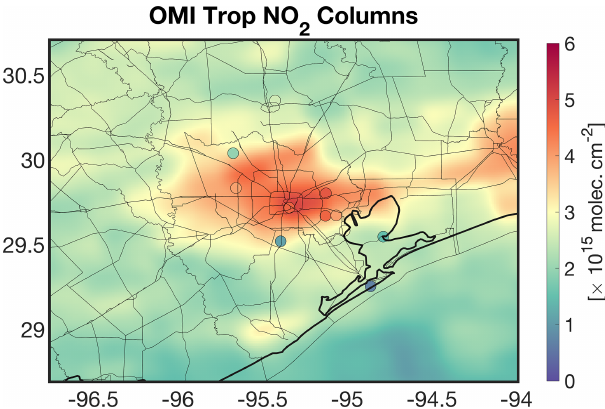
Figure 12. The spatial distribution of OMI tropospheric NO 2 columns oversampled at the resolution at 0 . 2 × 0 . 2 ◦ over Hous- ton in September 2013. The plot is overlaid by the surface Pan- dora spectrometer instrument averaged over the same month. The surface measurements originally measured the total columns; there- fore, we subtract the stratospheric columns provided by the OMI data (2 . 8 ± 0 . 16 × 10 15 moleculescm − 2 ) from the total columns to focus on the tropospheric